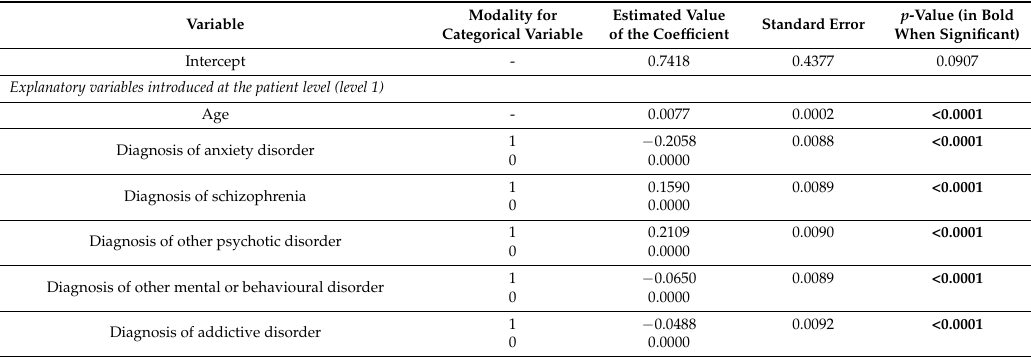
Table 5. Estimation of fixed effects in the final model (model